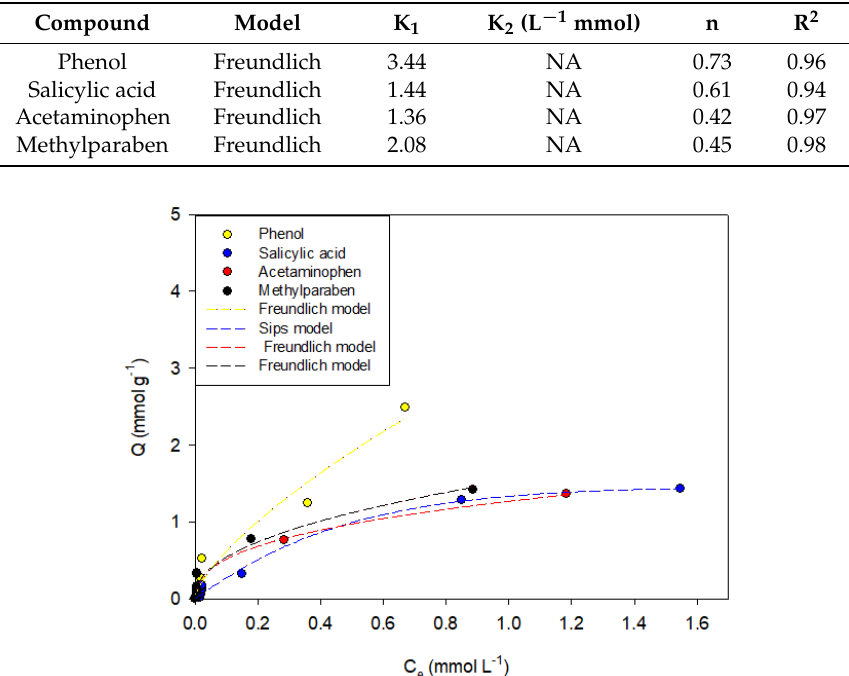
Figure 6. Adsorption isotherm of phenol, acetaminophen, salicylic acid, and methylparaben on activated carbon CAR1173 at 293 K. Table 11. Parameters of Freundlich and Sips models for phenol, acetaminophen, salicylic acid, and methylparaben adsorption on activated carbon CAR1173.